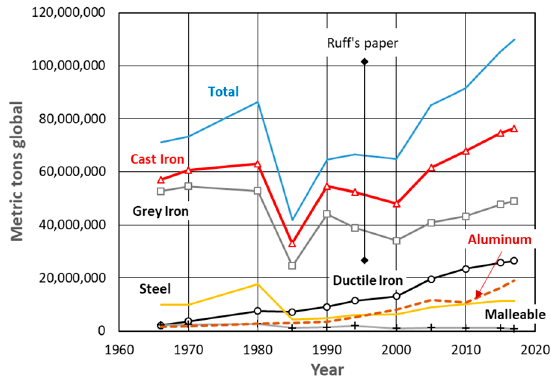
Figure 2. Yearly trends in global metric tonnage of casting production; reproduced from [4] with permission from American Foundry Soc, 2019.